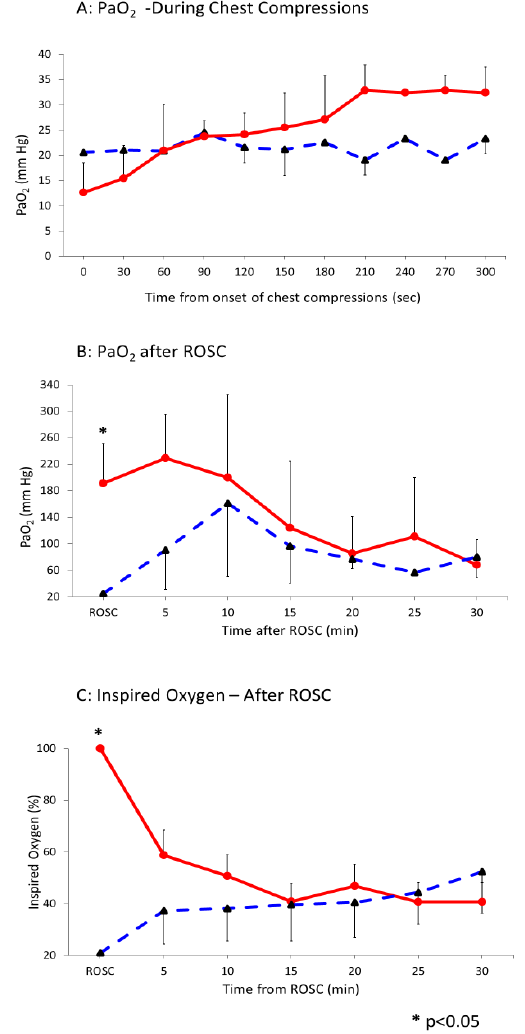
Figure 1. Interrupted line represents 21% and continuous line 100% oxygen. Data presented as average and standard deviation. ( A ) Arterial oxygenation (PaO 2 mm Hg) during chest compressions (CC). ( B ) Arterial oxygenation (PaO 2 mm Hg) after return of spontaneous circulation (ROSC). ( C ) The change in fraction of inspired oxygen after